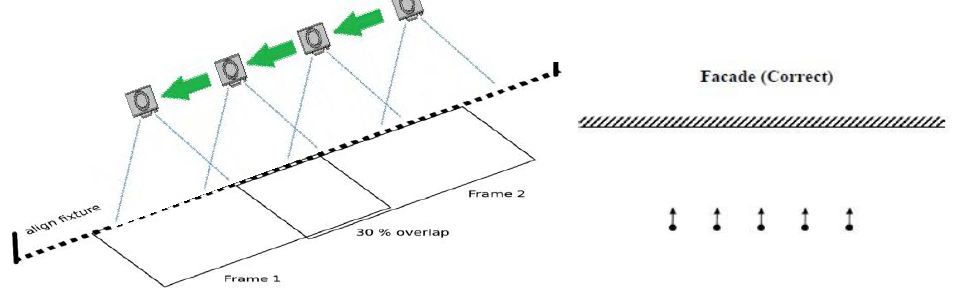
Figure 1. Acquisition scheme for the sampling of roughness measurements with a single reference frame by photography capturing frame by photography capturing scenarios.